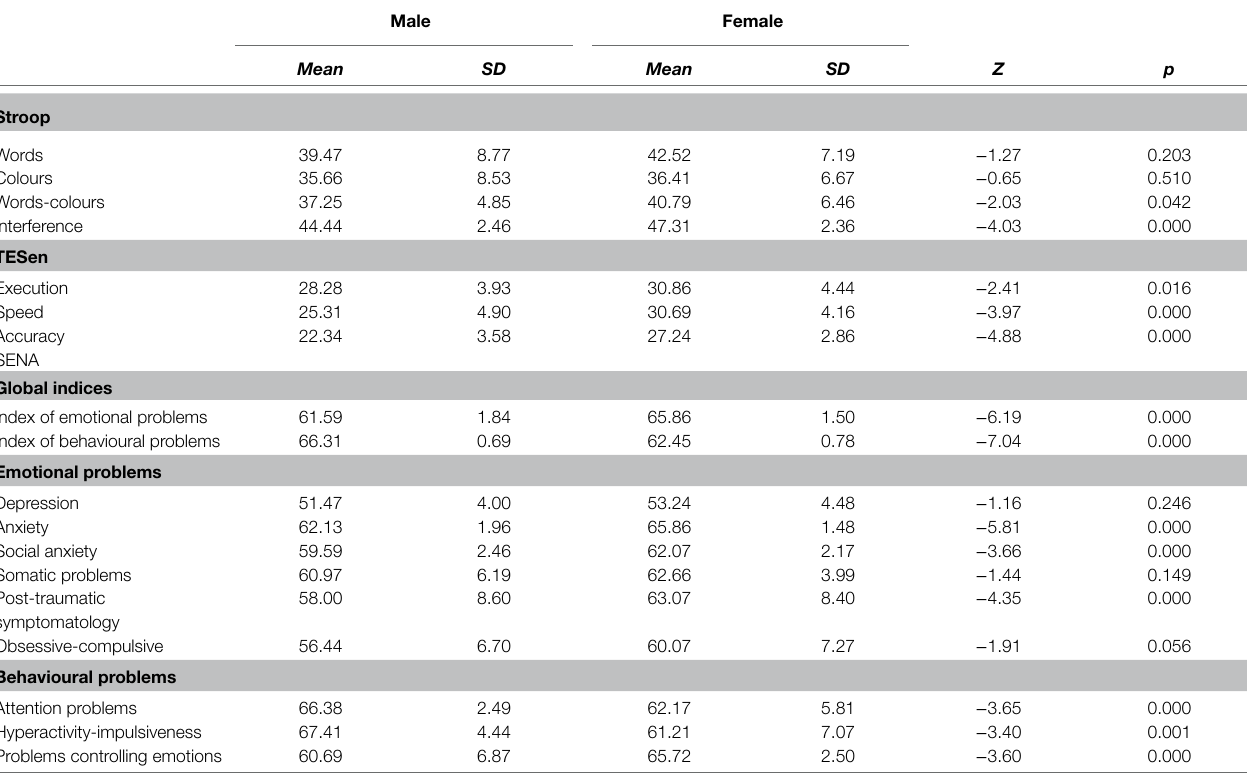
TABLE 2 | Mann-Whitney U test relating to the executive processes and emotional and behavioural problems according to gender. Male Female Mean SD Mean SD Z p